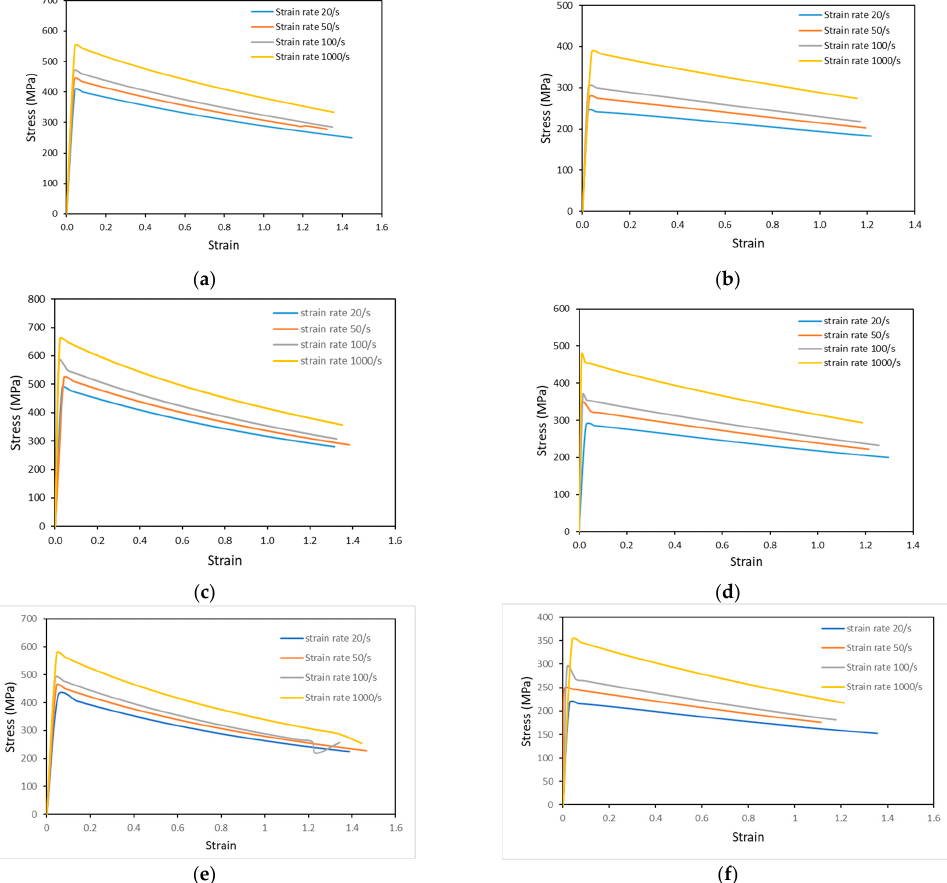
Figure 4. Flow stress obtained from DEFORM-3D simulation at high strain rates for ( a ) Ti-4.5Al-1V-3Fe at 800 °C; ( b ) Ti-4.5Al-1V-3Fe at 900 °C; ( c ) Ti-6Al-1V-3Fe at 800 °C; ( d ) Ti-6Al-1V-3Fe at 900 °C; ( e ) Ti-6Al-4V at 800 °C; and ( f ) Ti-6Al-4V at 900 °C. To validate the simulation results, the peak stress obtained from the Gleeble experi- ment and that of the DEFORM-3D simulation were compared, and the peak stress values were similar. The difference in the peak flow stress values was 15% for a strain rate of 20/s and 6% for a 50/s strain rate, respectively (Table 3). This difference is lower than the ~19% obtained for a much lower strain rate of 10/s. These trends indicate that, in the absence of SHPB, high strain rate uniaxial compression data can be obtained from DEFORM-3D sim- ulation in as much as the constitutive constants have been established from experimental data at lower strain rates.